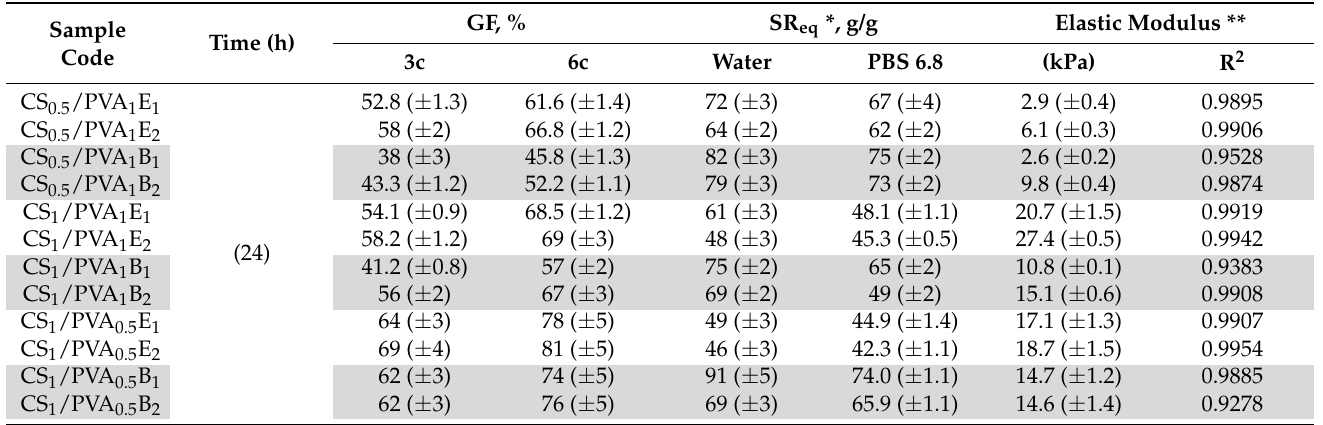
Table 1. The influence of synthesis parameters on the main characteristics of CS/PVA